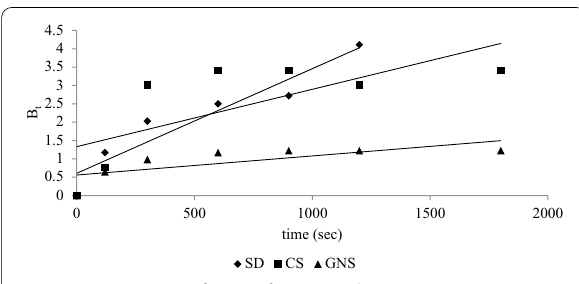
Fig. 12 B t vs t at 30 °C for 1 g of SD, CS and